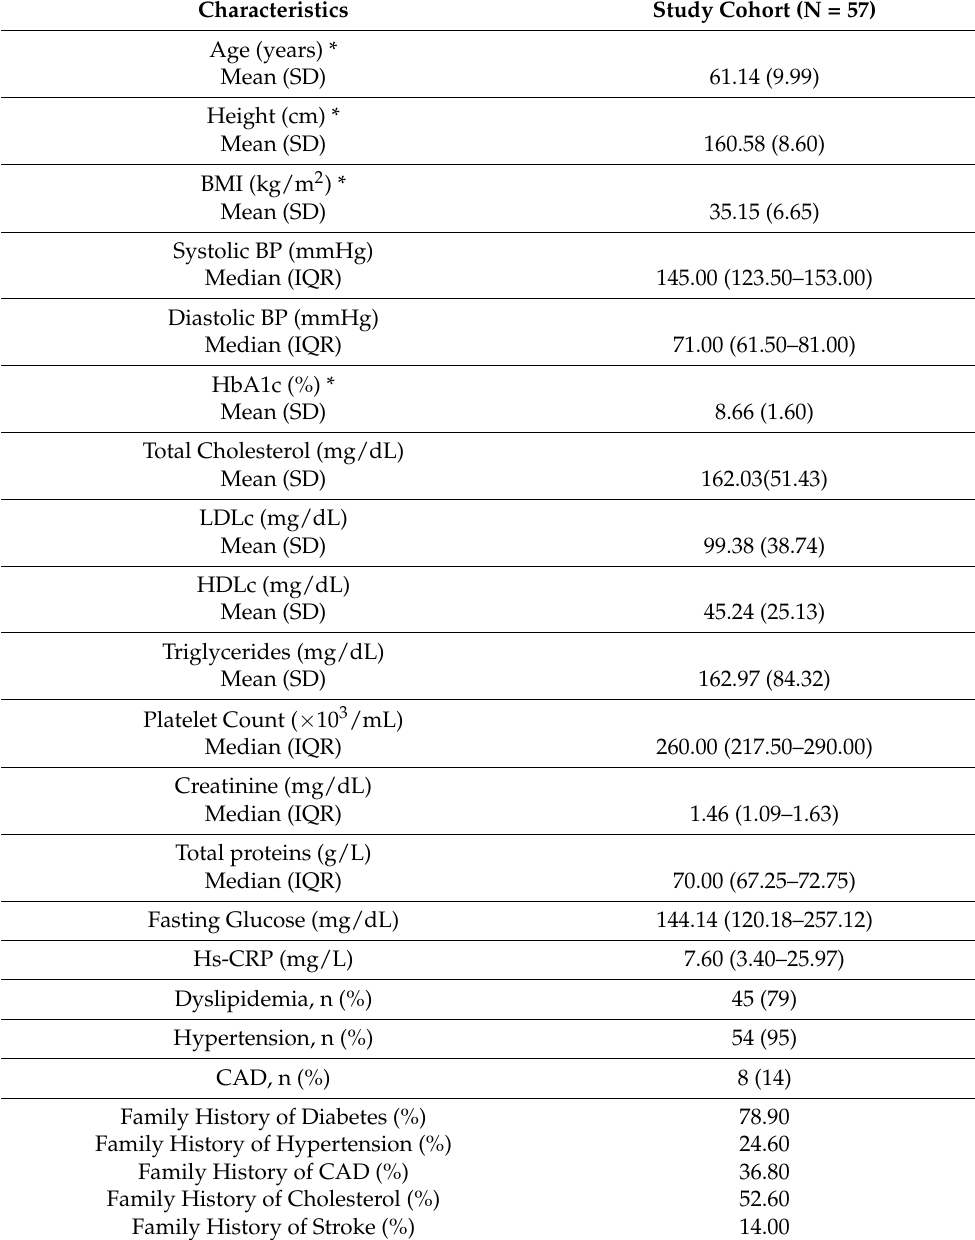
Table 1. Characteristics of the study